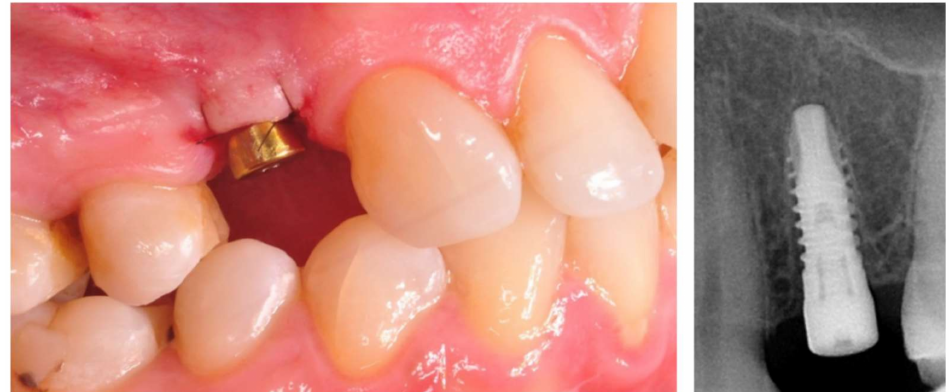
Figure 1. Implant with the healing abutment placed in bicuspid region and left for open healing.